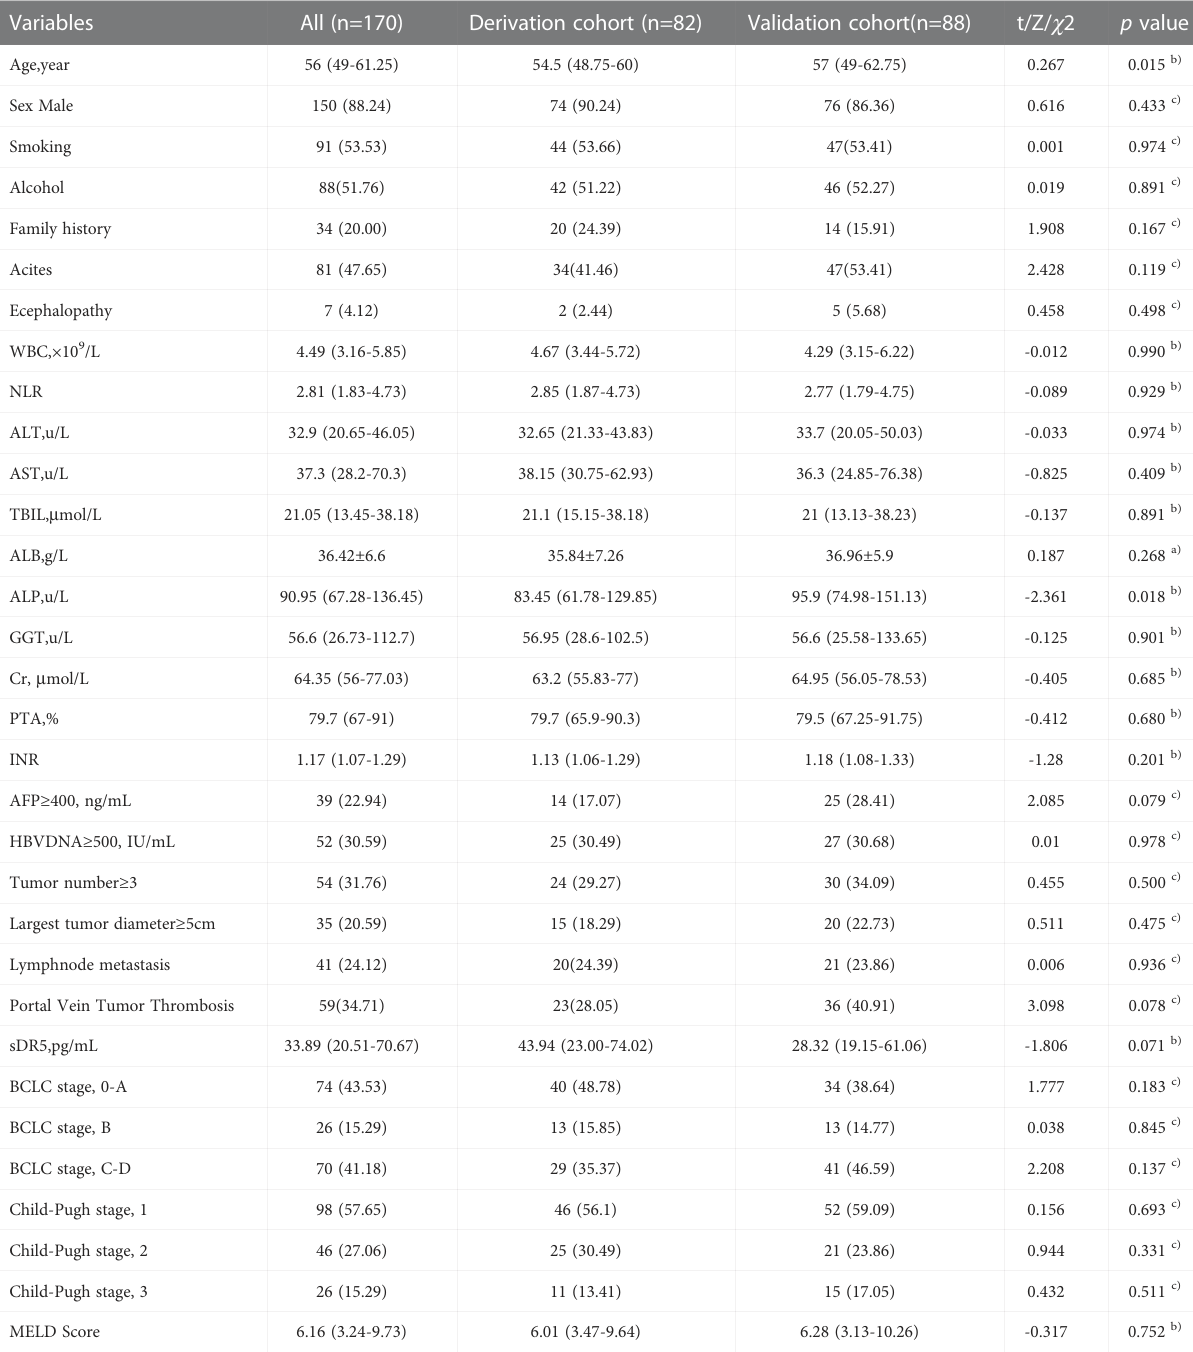
TABLE 1 Clinical characteristics of patients with HBV-related hepatocellular